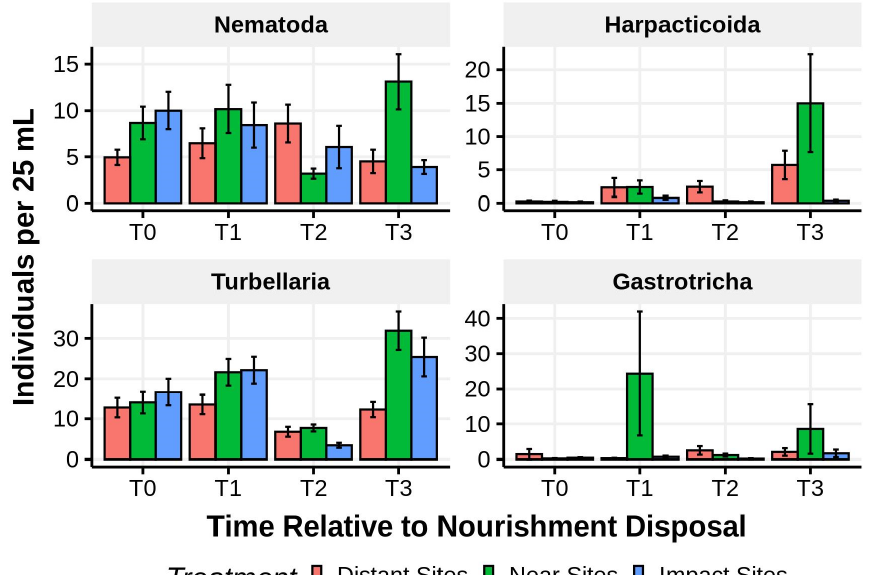
Figure 16. Mean (±1 SE) abundances of major taxa in the lower intertidal of sites directly receiving dredge spoil (impact sites), sites bordering the impact area (near control sites), and sites 3–5 km